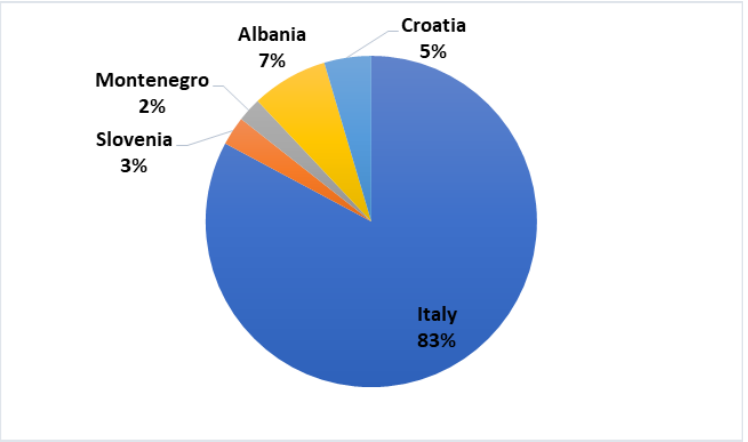
Figure A14. Percentages of BW discharged in the Port of Ploˇce sourced from the Adriatic Sea by coastal